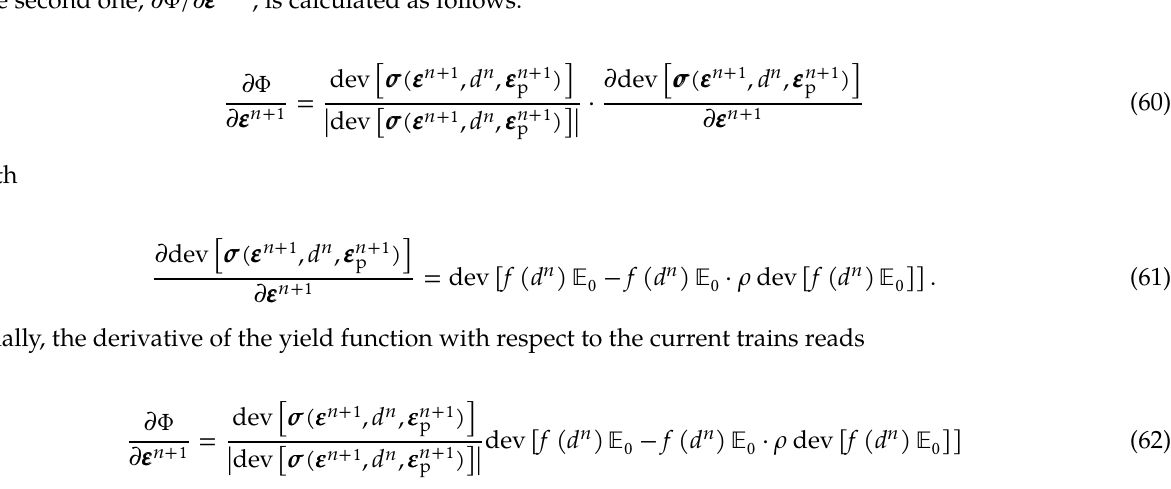
Table 1: Parameters for the respective